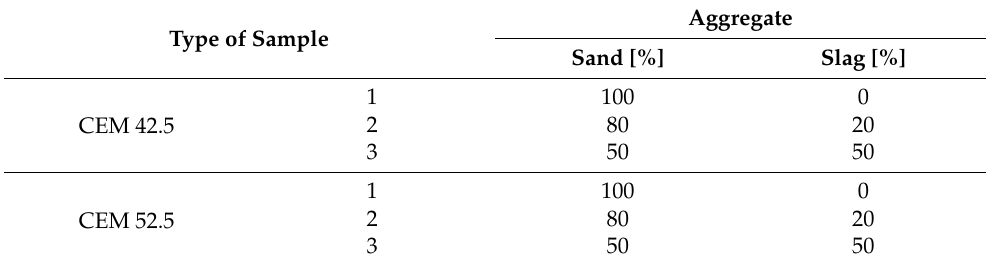
Table 5. Legend of mortar’s type.